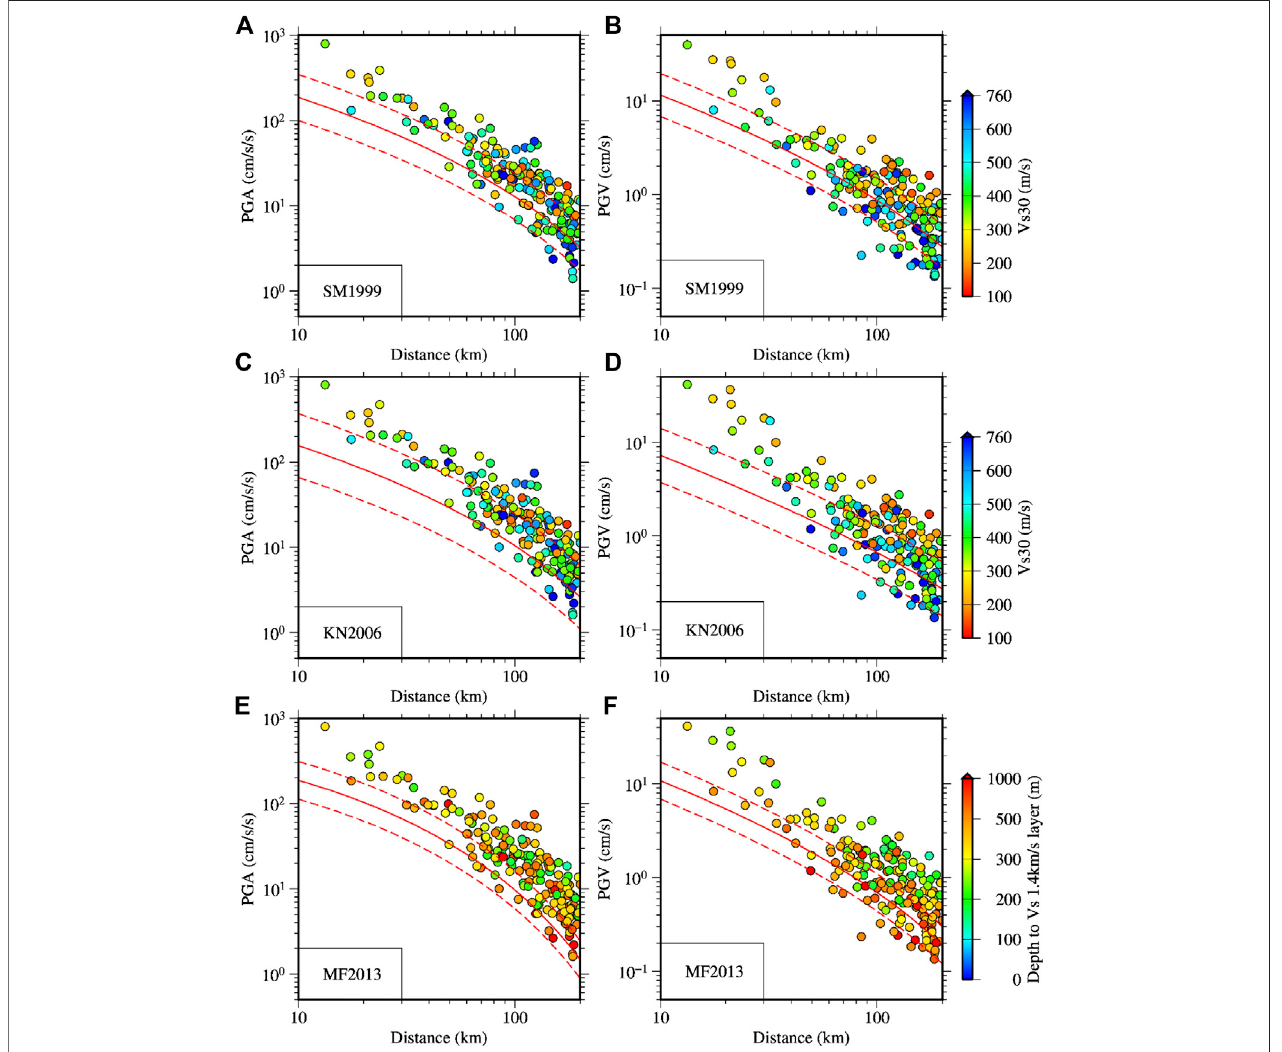
FIGURE 10 | Comparison of the observed PGAs and PGVs during the Mw 5.5 North Osaka earthquake with the ground motion prediction curves. The horizontal axes denote the hypocentral distance. The data points in panels (A – D) are color-coded by Vs30 values while the data in (E,F) are by depth to Vs 1.4 km/s. The used prediction equations are indicated in each panel by alphanumeric codes. The codes SM 199, KN 2006, and MF 2013 mean the prediction equations in Si and Midorikawa (1999), Kanno et al. (2006), and Morikawa and Fujiwara (2013), respectively.